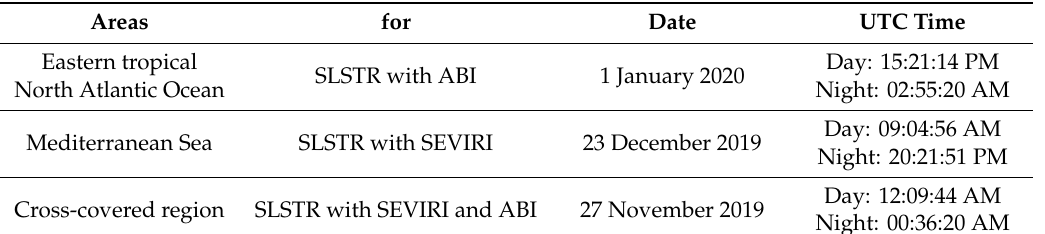
Table 3. Details of the SLSTR L1-B data used in this